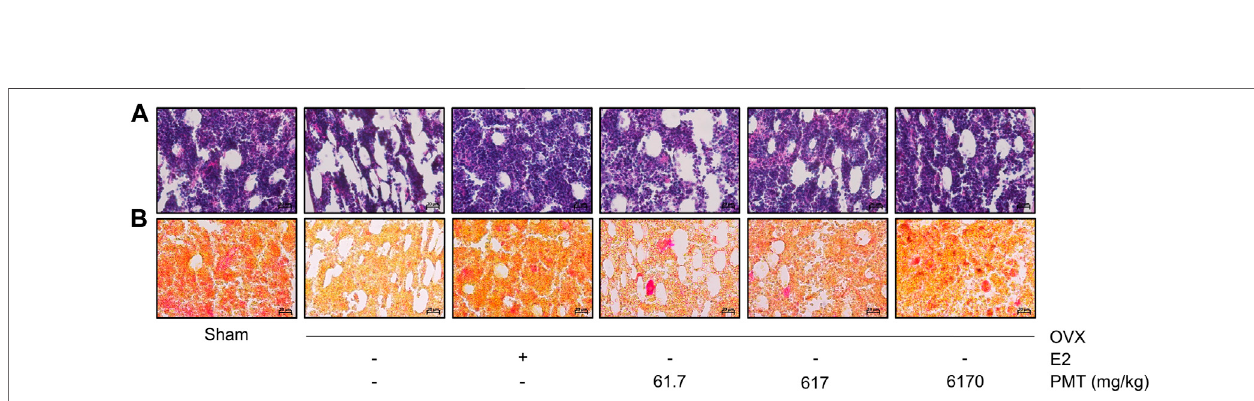
FIGURE 2 | Effects of PMT on histological changes in femur. Evaluation of histological changes using hematoxylin and eosin staining for bone marrow cavity and picrosiriusred stainingfordetecting depositionofcollagen.Magni fi cationofimageswere × 400.OVX,ovariectomizedgroup; E2,17 β -estradiolgroup;PMT, Palmul -tang soft